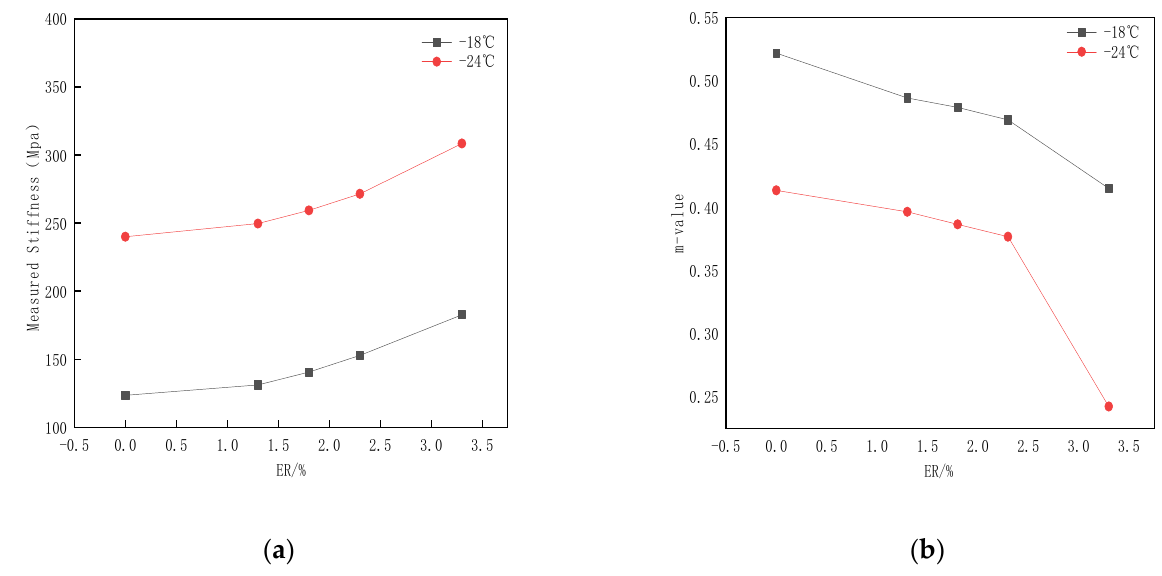
Figure 17. Effect of ER content on the low temperature performance of SBS modified bitumen: ( a ) Effect of ER content on the stiffness modulus; ( b ) Effect of ER content on the creep rate.